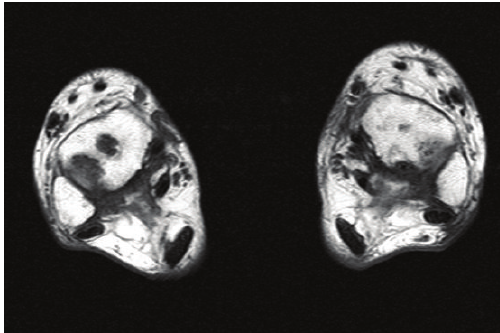
Figure 10: MRI TSE T1 axial view of the ankles at the level of the talar